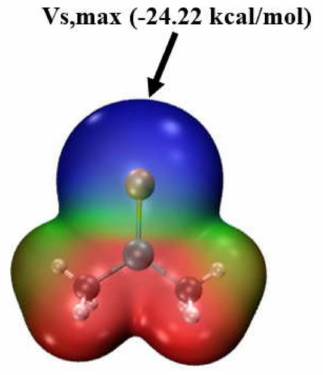
Figure 1. The molecular electrostatic potential map for isolated monomer 18, (CH 3 ) 2 GeSe in water solvent geometry, indicated on the contour of 0.001 au electron isodensity. Colour scale is from − 0.03 au (blue) to +0.03 au (red).